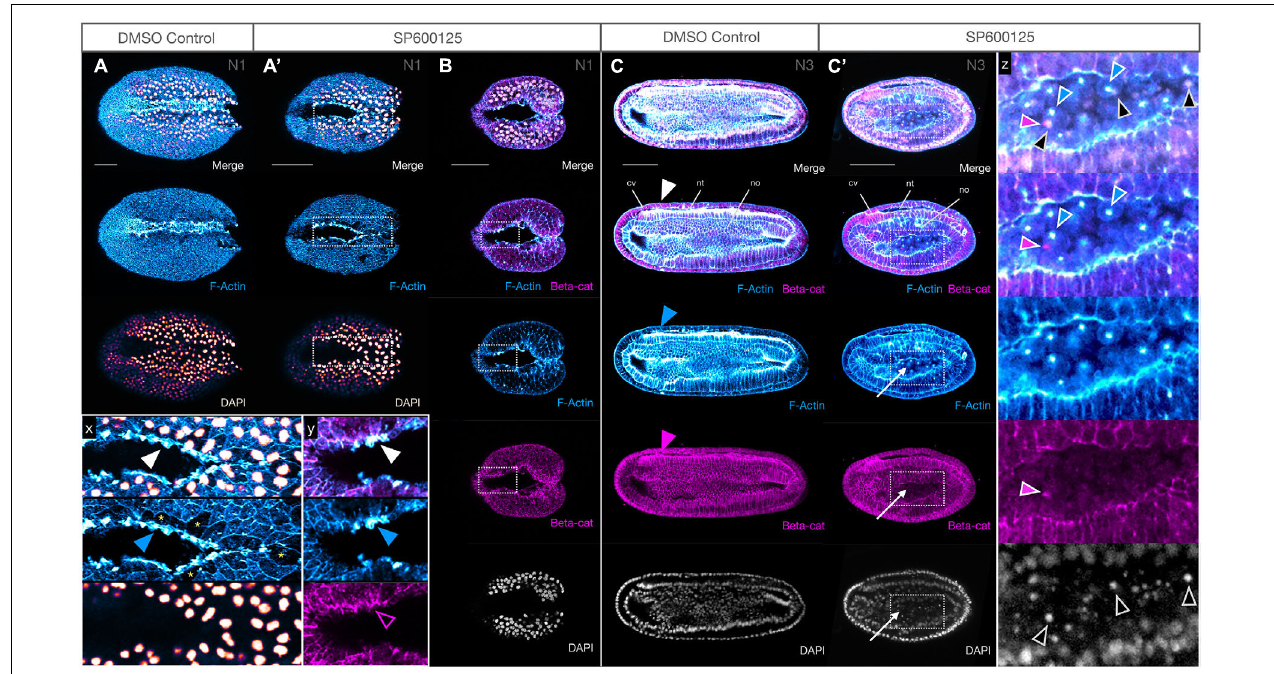
FIGURE 3 | JNK inhibition produces no major defects in epidermal fusion or neural tube closure. (A,A (cid:48) ) Phalloidin staining of F-Actin (blue) in apical membranes shows epidermal fusion in SP600125-treated embryos proceeds similarly, but more slowly, in treated embryos (A (cid:48) ) relative to DMSO controls (A) at N1 stage. Inset x clearly shows an accumulation of F-Actin in the leading edge (white arrowheads) of fusing epidermal sheets along the midline. Cells with such protrusions experiencing tension after having just fused, or in the process of fusion, appear to be depleted in cytoplasmic F-Actin (yellow asterisks). Dorsal views are shown. (B) Immunohistochemistry of β -catenin (beta-cat, magenta) shows that the accumulation of F-Actin in leading edge cells is not accompanied by concomitant accumulation of β -catenin (inset y, arrowheads). Dorsal views shown. (C,C (cid:48) ) By N3, the neural folds have fused into a closed neural tube in both controls (C) and SP600125-treated embryos (C (cid:48) , arrowheads) despite obvious morphogenesis defects. Cells accumulating within the archenteron contain central aggregates of F-Actin (white arrows) and pycnotic nuclei (DAPI) (inset z, coloured arrowheads show non-correspondence of nuclear fragments and F-Actin aggregates, and general absence of β -catenin except as infrequent and generally microscopic puncta). Representative embryos are shown. Lateral views shown. In all cases, anterior is to the left. cv, cerebral vesicle; nt, neural tube; no, notochord. Scale bars = 50 µ